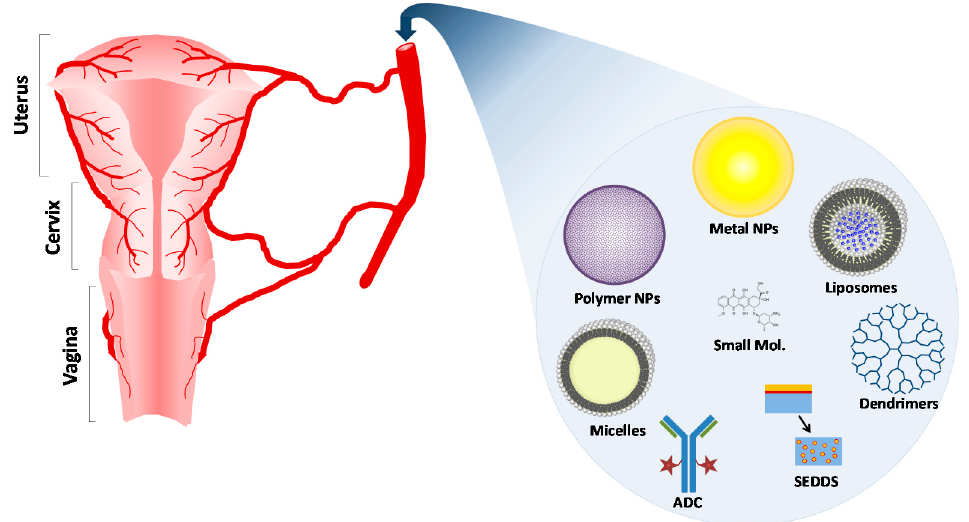
Figure 2. Systemic Drug Delivery systems used in cervical cancer, including metal nanoparticles, polymer nanoparticles, liposomes, micelles, Antibody–Drug Conjugates (ADCs), Self-Emulsifying Drug Delivery Systems (SEDDSs) and dendrimers.